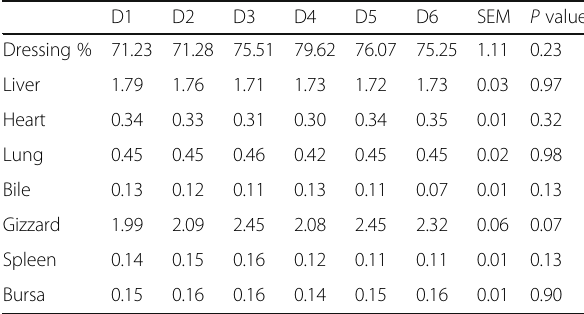
Table 4 Effects of pawpaw leaf and seed meal composite mix (PCM) supplementation on carcass and relative internal